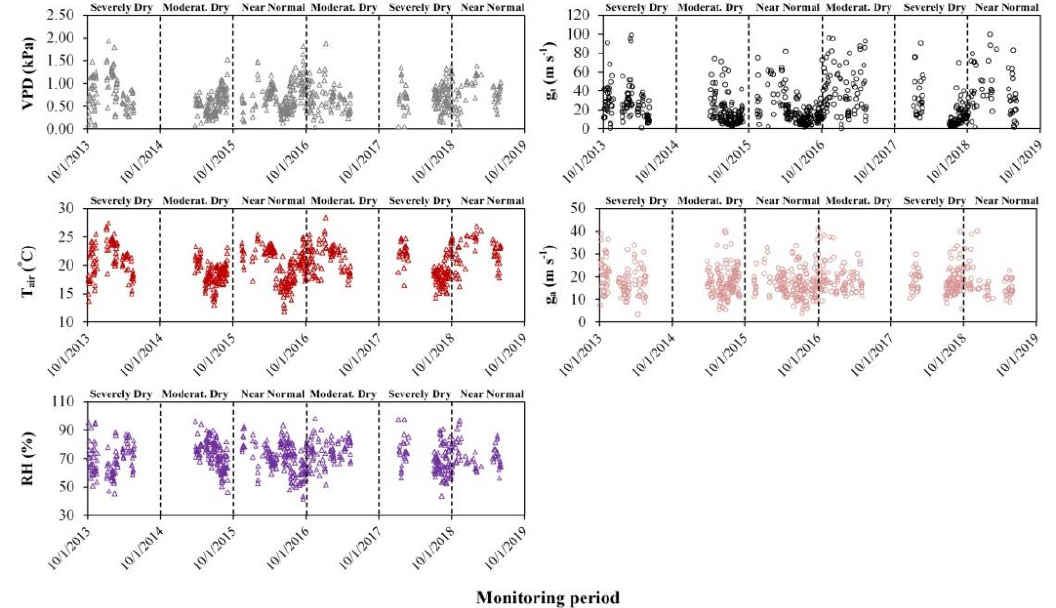
Figure 7. Seasonal variation of the vapor pressure deficit (VPD) ( upper left ), air temperature (T air ) ( middle left ), relative humidity (RH) ( lower left ), bulk surface conductance (g s ) ( upper right ), and aerodynamic conductance (g a ) ( middle right ) in six hydrological years (2013 to 2019) in different weather conditions (severely dry, moderately dry, and near normal).